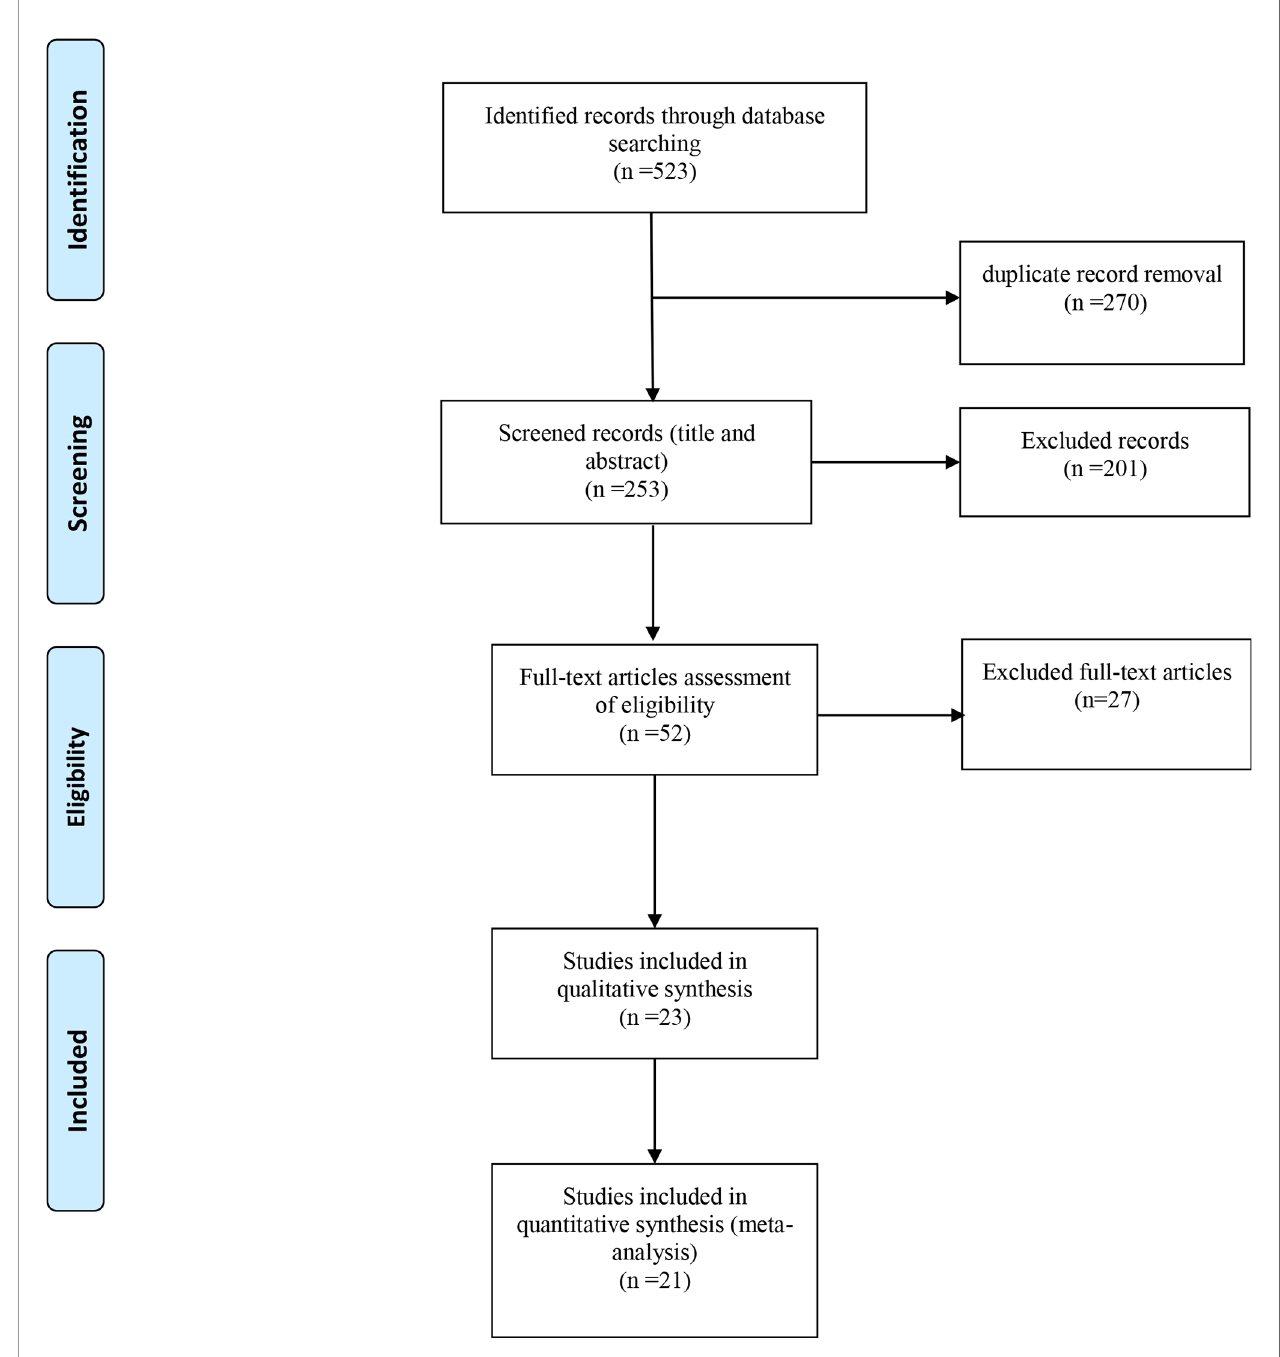
FIGURE 1 | Studies search and review fl